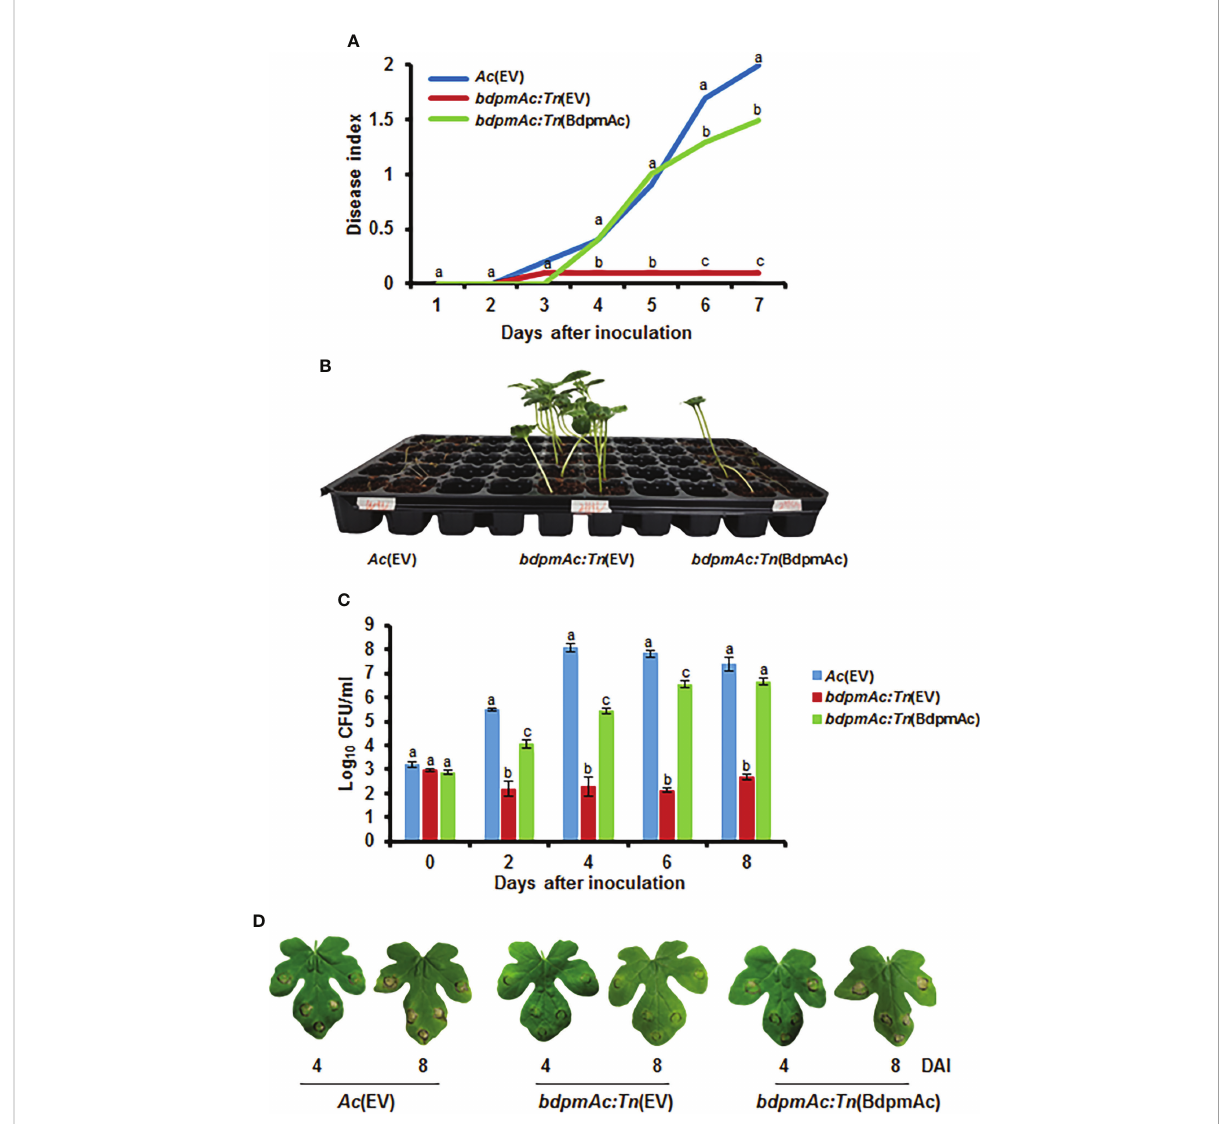
FIGURE 1 Virulence assay for Ac (EV), bdpmAc:Tn (EV), and bdpmAc:Tn (BdpmAc). (A) Disease index of the inoculated germinated seeds at 7 days after inoculation. Disease index: [(number of plants with no symptoms)×0 + (number of plants with spots)×1 + (number of plants presenting wilting)×2]/Total number of plants. (B) Photograph of the germinated seed inoculation. The image was taken 7 days after inoculation. Ten biological replicates were used for each strain. (C) Variations in cell numbers in the leaf in fi ltration experiments after 8 days using the colony counting method. Three biological replicates with three technical replicates were evaluated for each strain. (D) Photograph of the leaf in fi ltration experiment. The images were taken 4 and 8 days after inoculation. Different letters above the error bars indicate signi fi cant differences according to ANOVA (p<0.05) with Tukey ’ s HSD test and the error bars indicate the standard errors of means. Five independent experiments were conducted, all of which showed similar